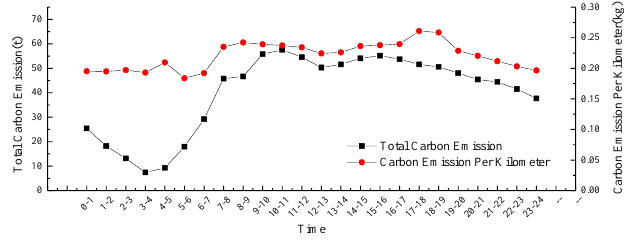
Figure 9. Carbon emissions throughout one day.